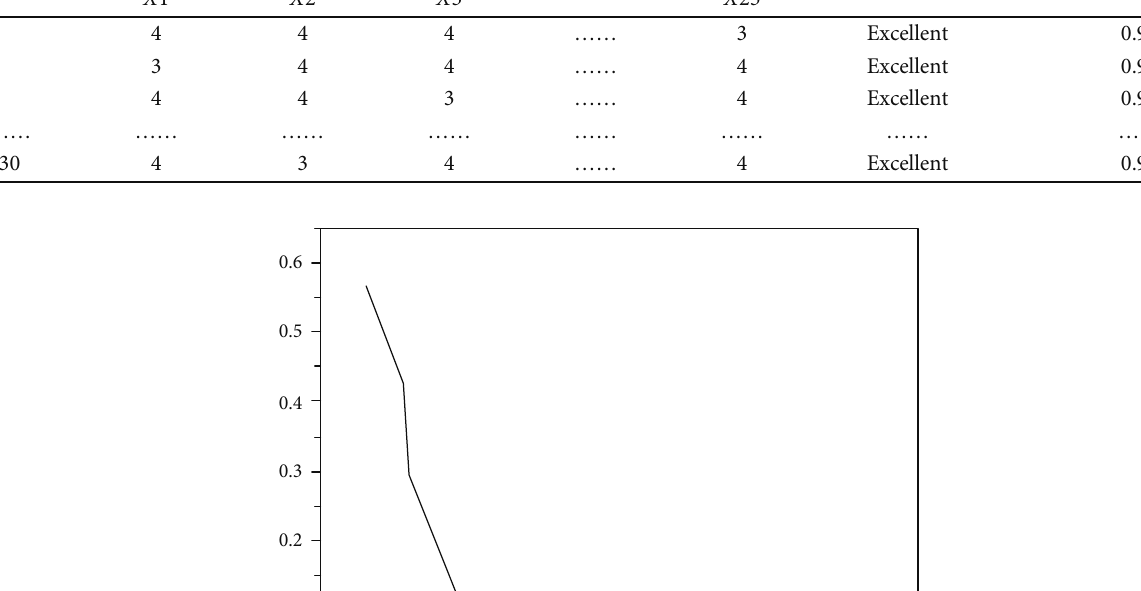
Table 9: Partial evaluation sample data obtained from the questionnaire survey of the six courses.